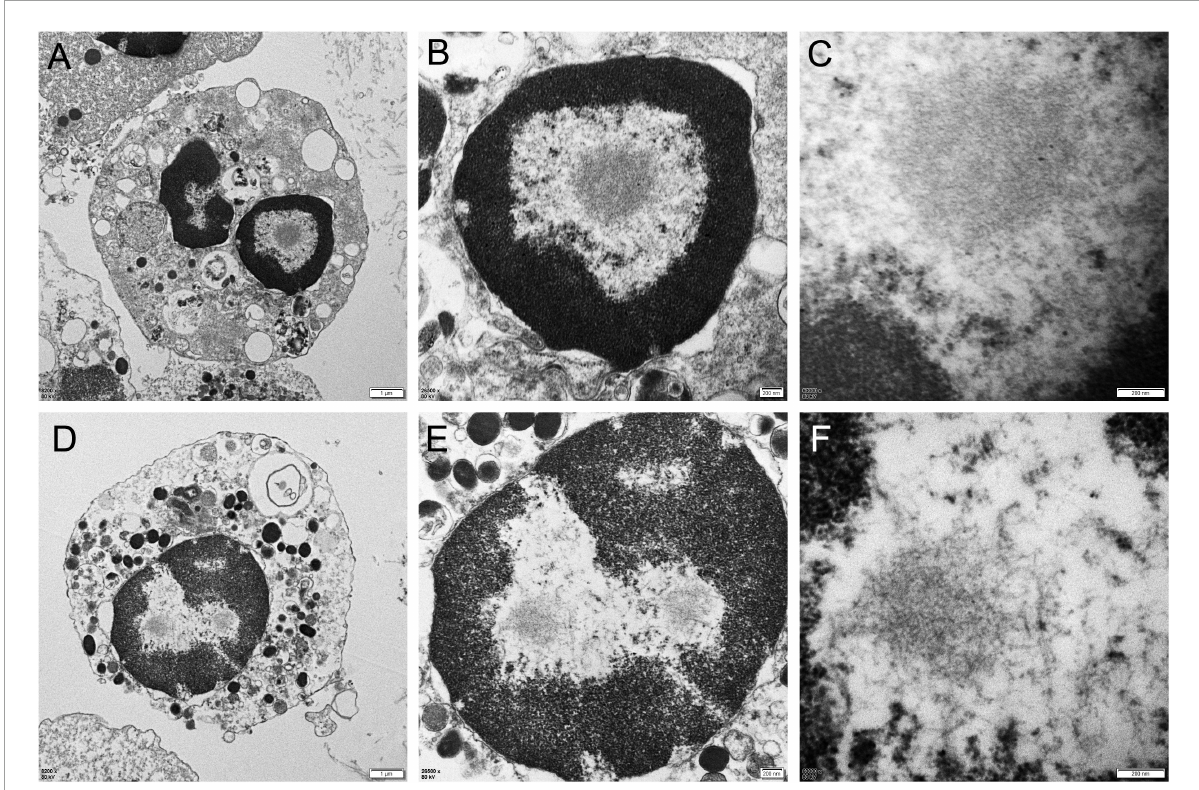
FIGURE5 Electron microscopy of urine sediment cells. In the patient 1, electron microscopy showed the appearance of filamentous inclusions in a neutrophil (Panels A–C were magnification). In the patient 6, electron microscopy showed the appearance of filamentous inclusions in a monocyte (Panels D–F were